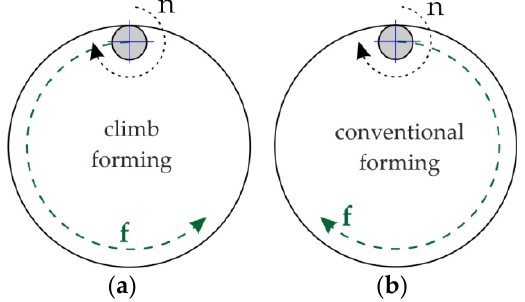
Figure 4. Spindle rotation: ( a ) anticlockwise; and ( b ) clockwise. Table 3. Plan of experiments for split-plot I-optimal design (“+”—clockwise direction, “ − “—counterclockwise direction of tool rotation).